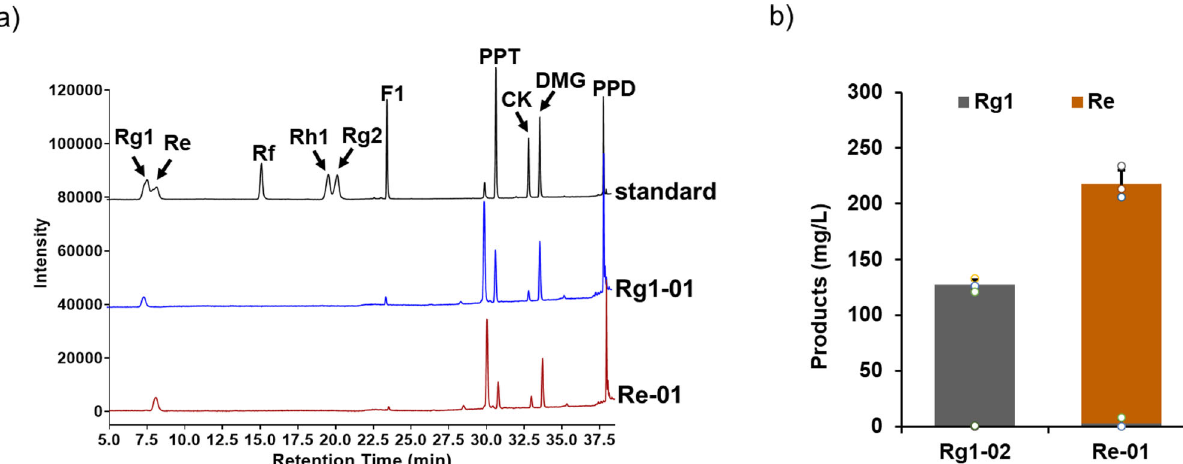
Fig. 5 Analysis of the ginsenoside Re production in engineered Saccharomyces cerevisiae strains . a HPLC analyses of Rg1, Re, F1, PPT, CK, DMG, and PPD produced in yeast strain Re-01. Mixed samples of ginsenosides were monitored as standards. The Rg1 chassis strain Rg1-02 was used as a negative control. b Quantitative analysis of Re and its related intermediate Rg1 in engineered yeast strains. All data represent the mean of n = 3 biologically independent samples and error bars show standard